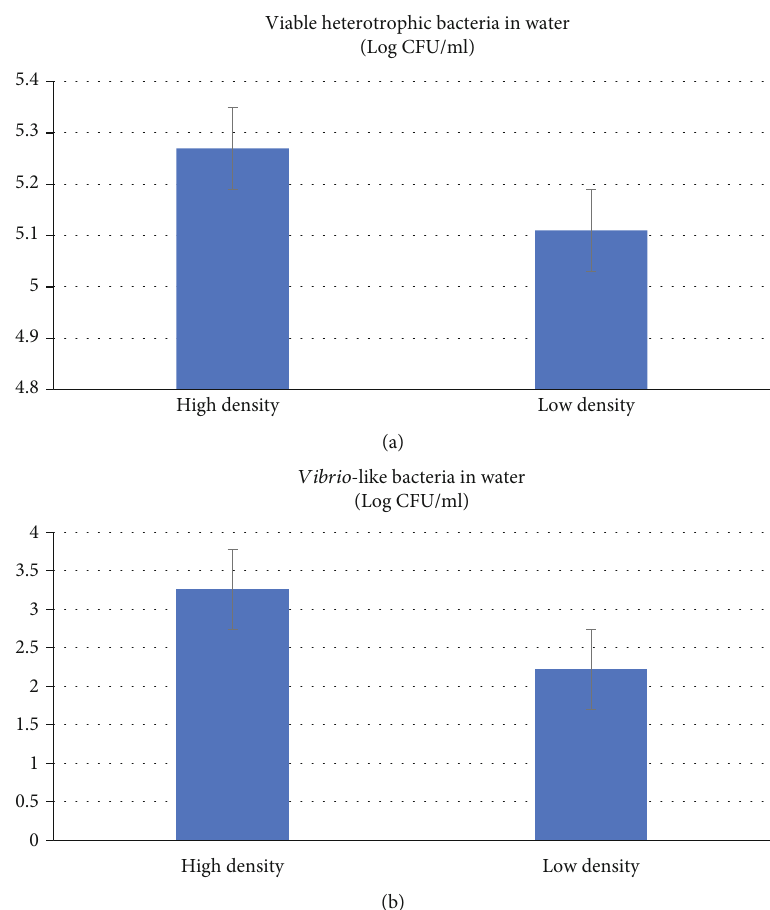
Figure 1: Viable heterotrophic bacteria count (a), and Vibrio -like bacteria count (b) (Log CFU/ml) from water collected from whiteleg shrimp ( L. Vannamei ) bio fl oc tanks under high (300/m 2 ) and low (100/m 2 ) stocking